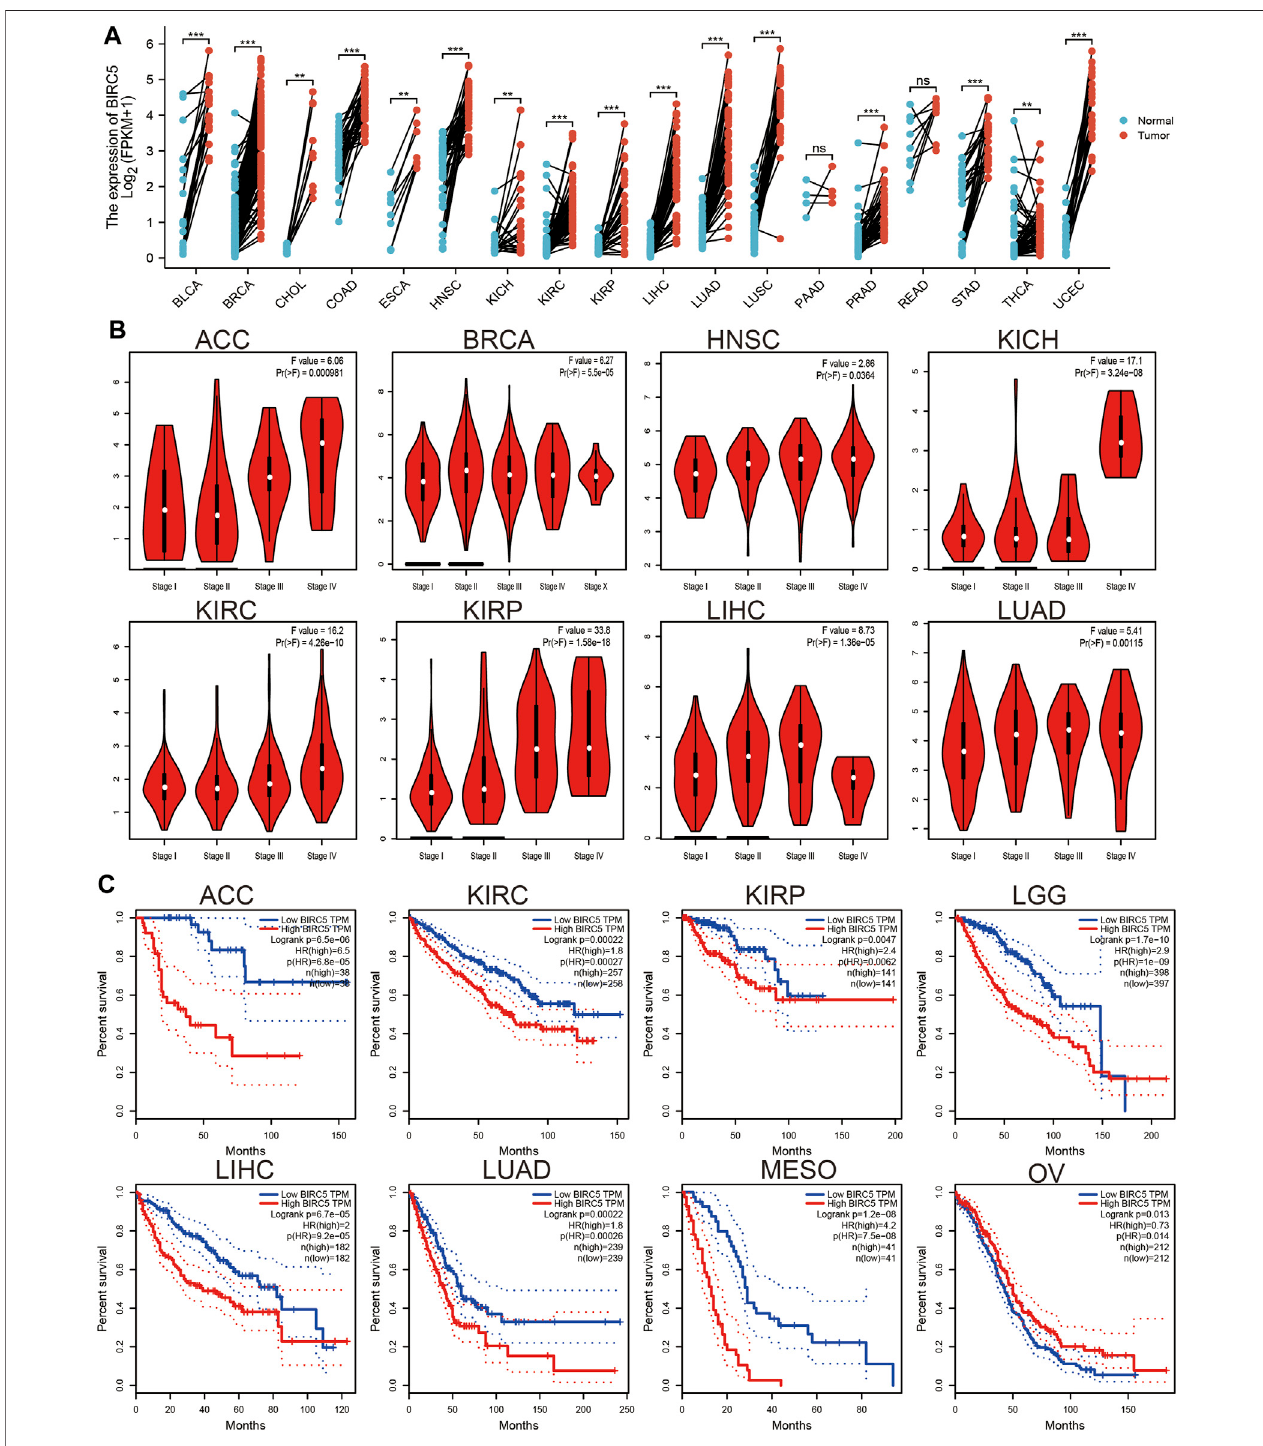
FIGURE 1 | BIRC5 expression and prognosis in patients with other cancer types. (A) Differences in expression of BIRC5in normal and tumor tissues of TCGA. (B) The pathological stage of BIRC5 in diverse cancer examine by UALCAN database. (C) Kaplan-Meier curves were drawn to evaluate the overall survival of BIRC5 in various human